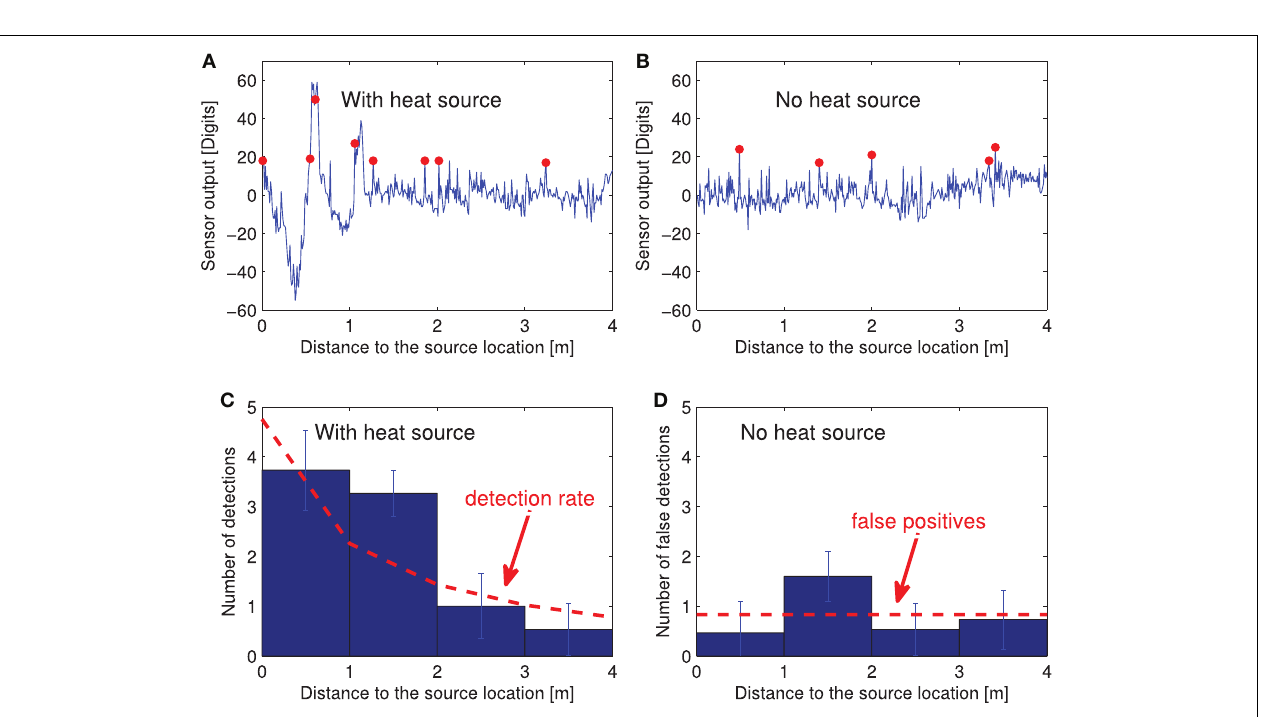
FIGURE 7 | Detection events with and without source . (A,B) Temporal evolution of the measured temperature as a function of the source distance when the robot moves straight toward the source location. The blue curve represents the local variation of the temperature; that is, the difference between the current temperature and a running average calculated over a 10-s sliding window. Red dots correspond to detection events triggered each time the